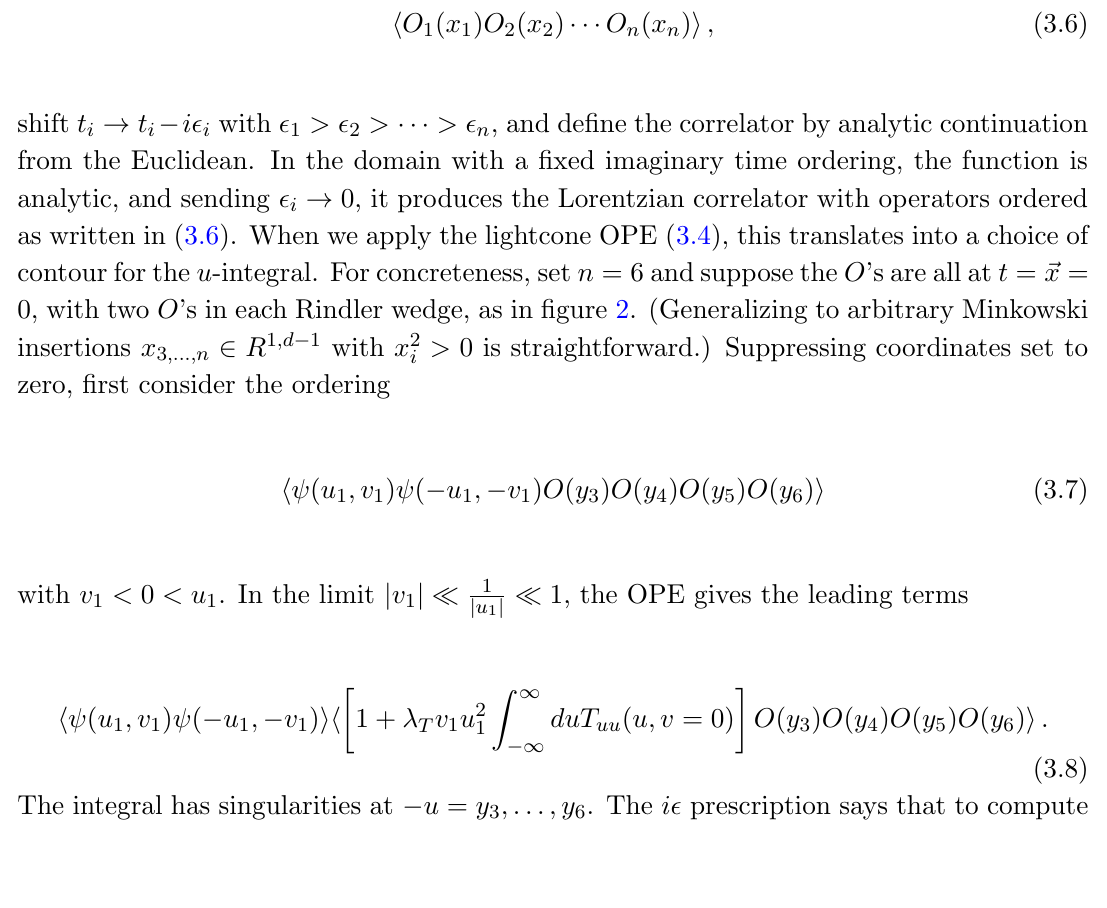
duT uu , integrated R